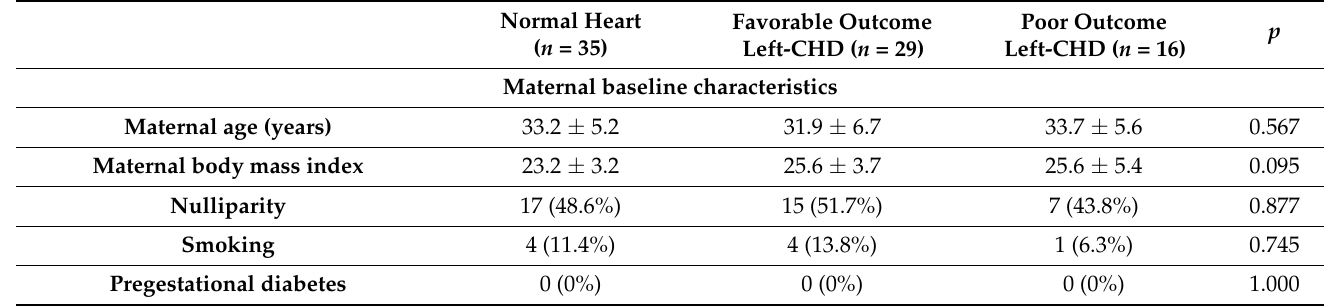
Table 1. Maternal baseline characteristics, standard ultrasound, and perinatal results in the study populations.